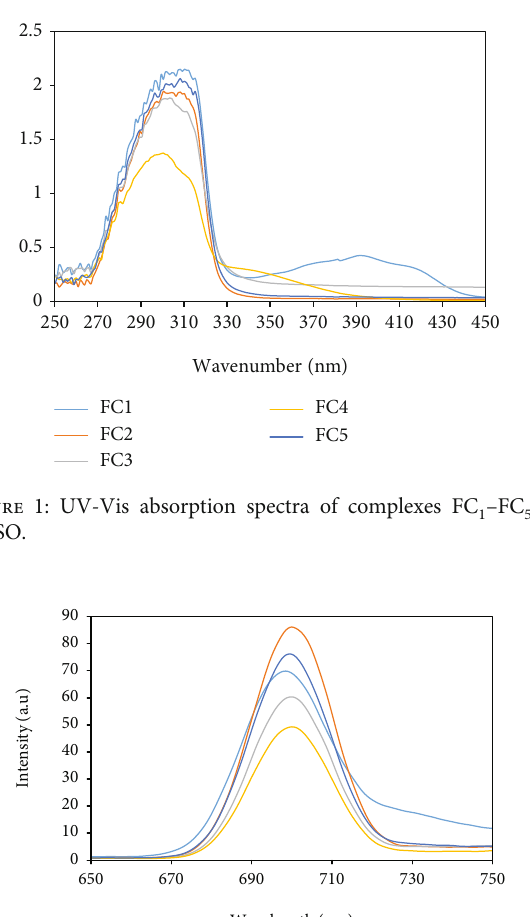
Figure 2: Emission spectra of the synthesized Ru(II) complexes (FC -FC ) in DMSO- d6 . 1 5